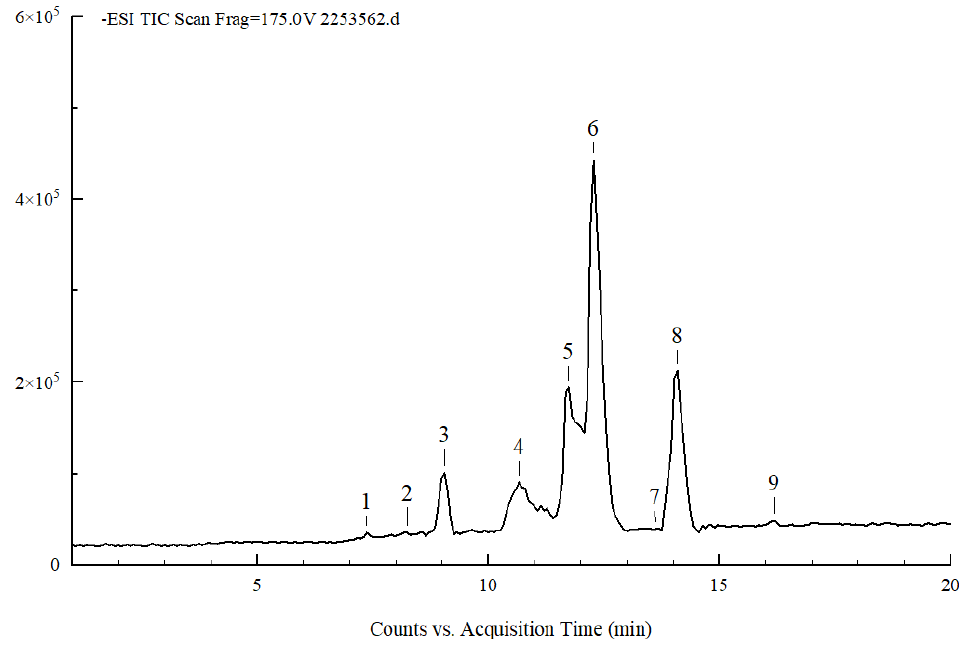
Figure 1. Total negative ion chromatogram of PSPc. Table 2. Mass spectrometry information of the main compounds in PSPc.